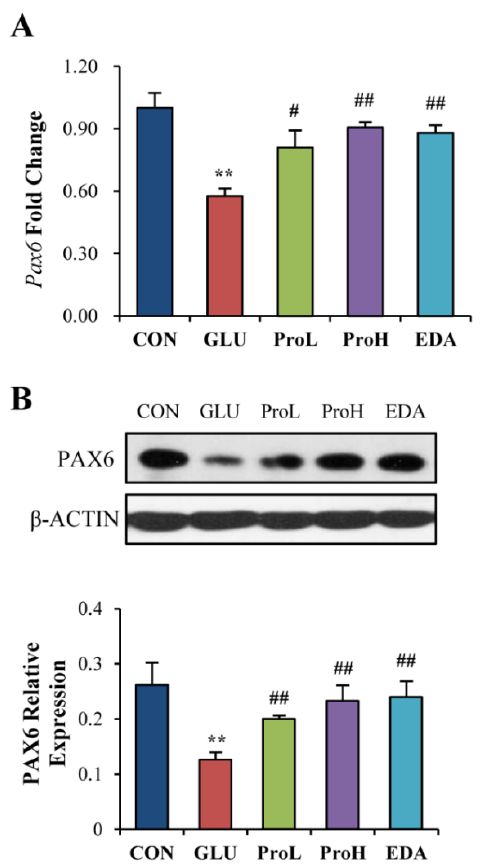
Figure 5. Proanthocyanidins restored the expression of eye development marker in the eye of chick embryo. Pax6 gene and protein levels ( A and B ) were determined in the eye of EDD 3.5 chick embryos. Values were expressed as mean ± SD in each group ( n = 10). ** p < 0.01 vs. control, # p < 0.05, ## p < 0.01 vs. glucose. CON: control, GLU: high glucose, ProL: 1 nmol/egg proanthocyanidins, ProH: 10 nmol/egg proanthocyanidins, EDA: edaravone.